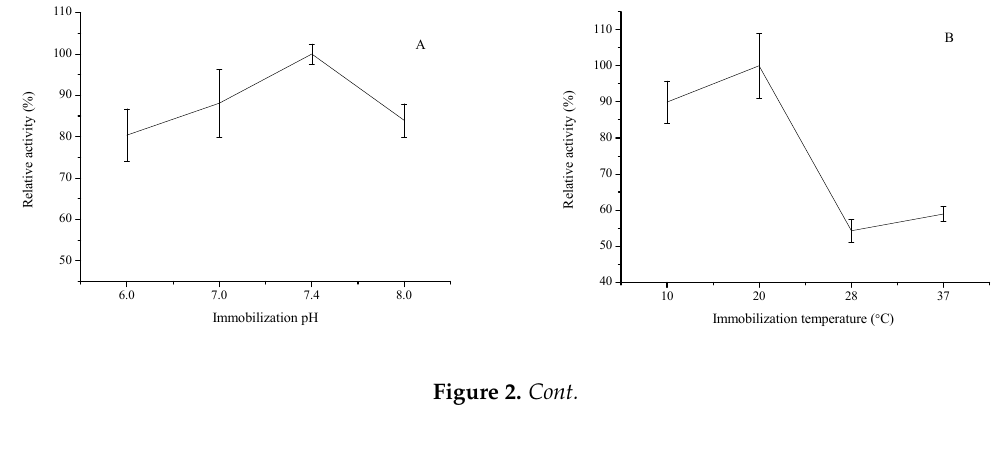
Figure 1. Effect of GA concentrations on the relative activity of the immobilized COX-2 ( n = 3).